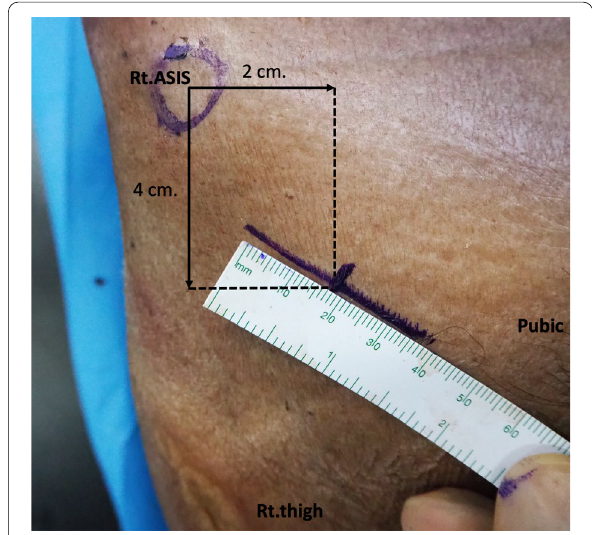
Fig. 1 Oblique bikini skin incision centered approximately 4 cm distal and 2 cm medial to the anterior superior iliac spine (or two fingerbreadths distal and one medial to the ASIS) on the right hemipelvis